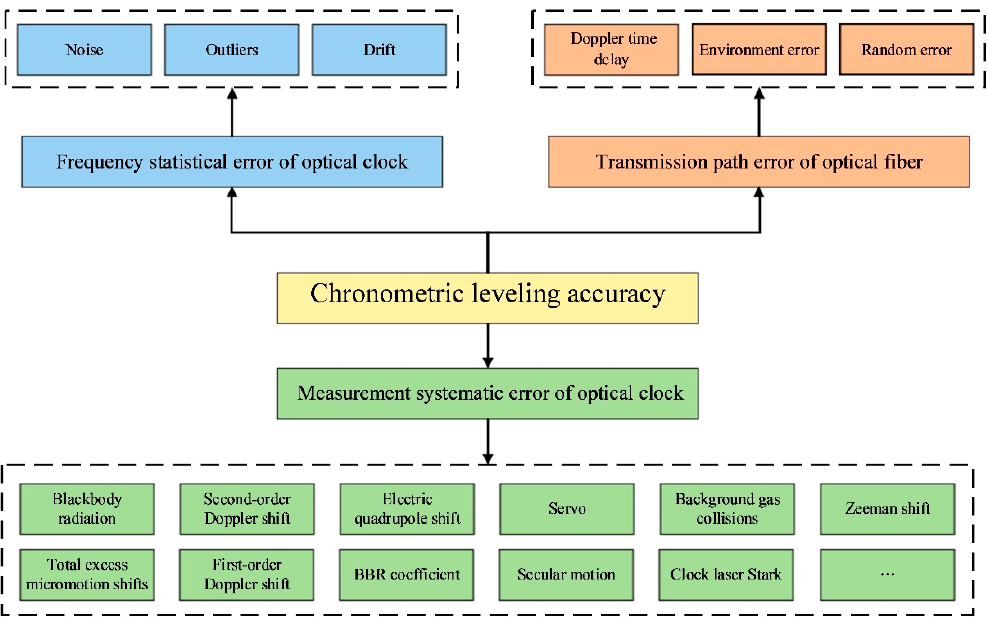
Figure 2. The main sources of error terms in chronometric leveling via OFFT.